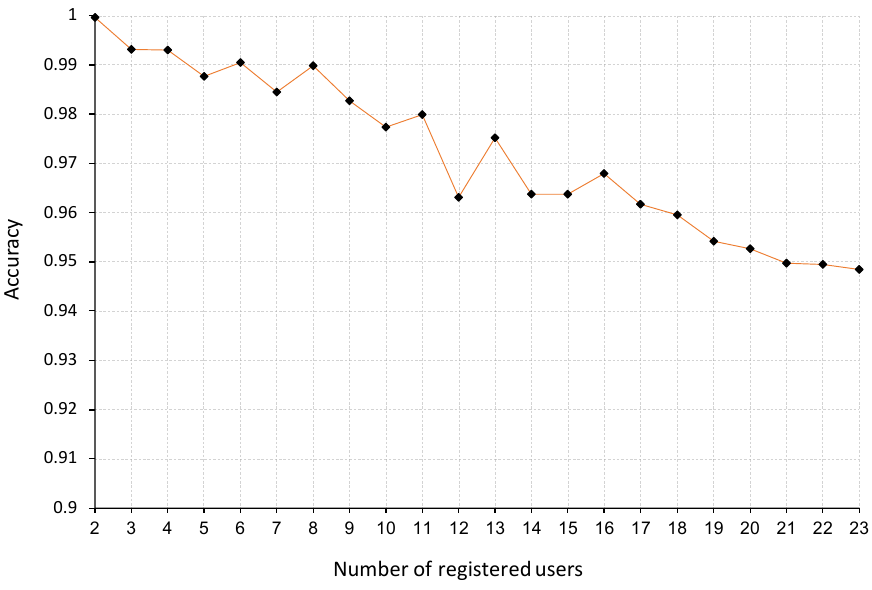
Figure 13. The performance according to the number of registered users.